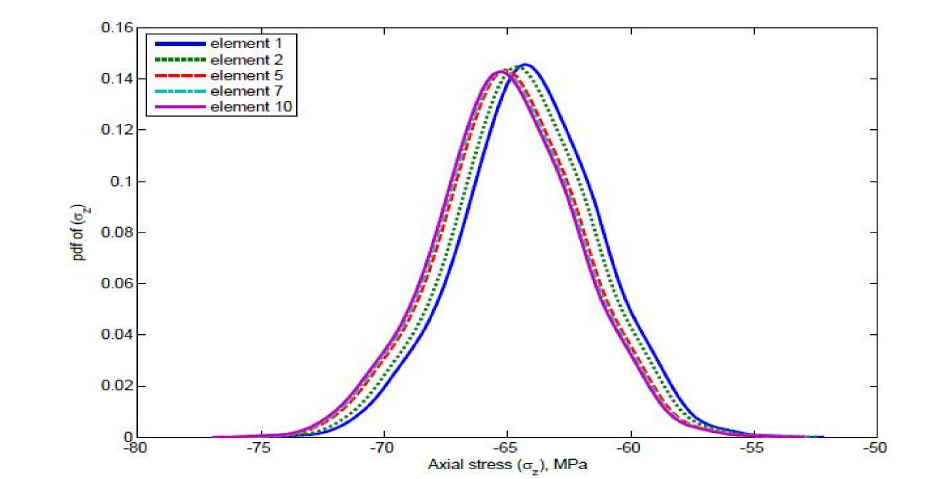
Figure 18. Comparison of radial stress and axial stress for different elements when E , P , and ∆ T are random variables.